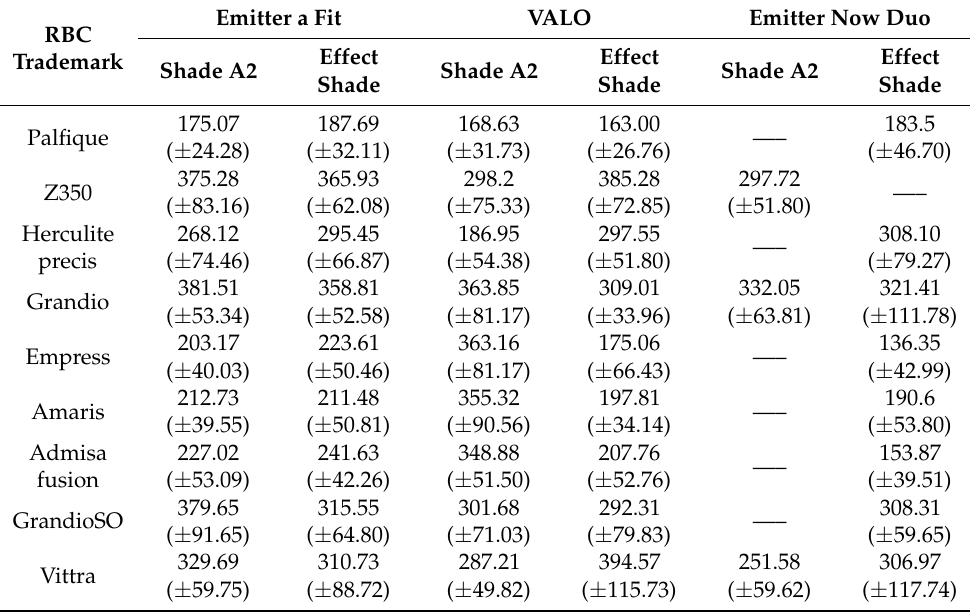
Table 7. Mean and standard deviation of the biaxial flexure strength test (in N) of resin-based composites of different shades cured with second- and third-generation LED units.